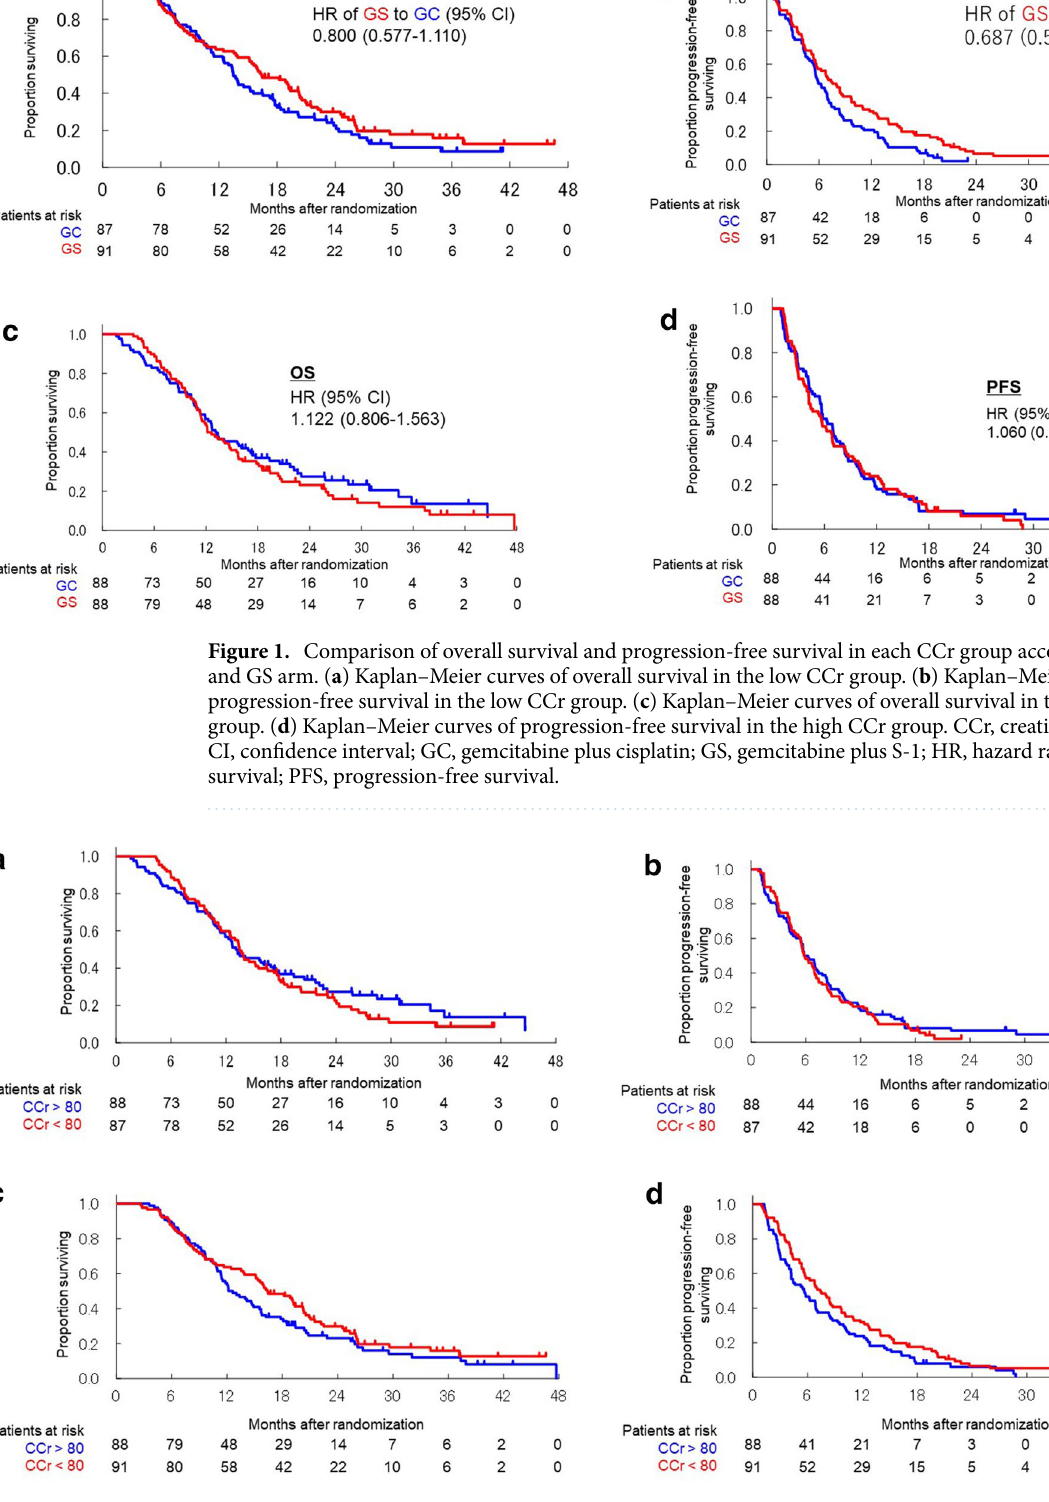
Figure 2. Comparison of overall survival and progression-free survival in the GC and GS arms according to the low and high CCr groups. ( a ) Kaplan–Meier curves of overall survival for GC. ( b ) Kaplan–Meier curves of progression-free survival for GC. ( c ) Kaplan–Meier curves of overall survival for GS. ( d ) Kaplan–Meier curves of progression-free survival for GS. CCr, creatinine clearance; CI, confidence interval; GC, gemcitabine plus cisplatin; GS, gemcitabine plus